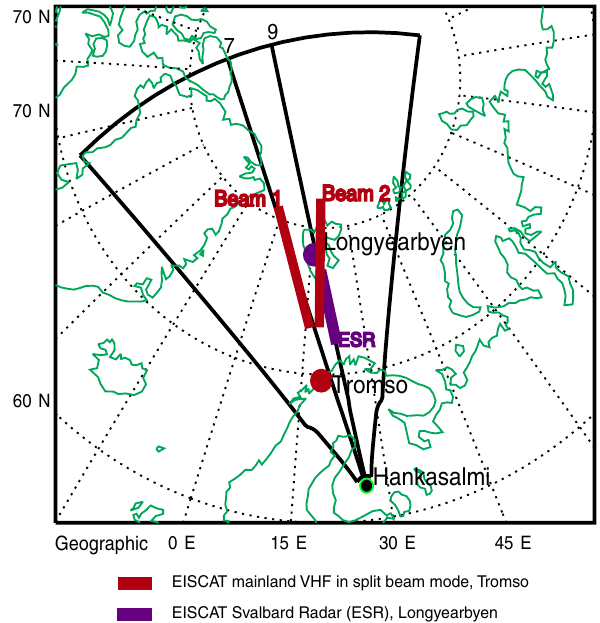
Fig. 1. Map showing the relative locations of the CUTLASS Fin- land field of view, including beams 7 and 9, and the beams of the EISCAT and ESR radars used in the following case